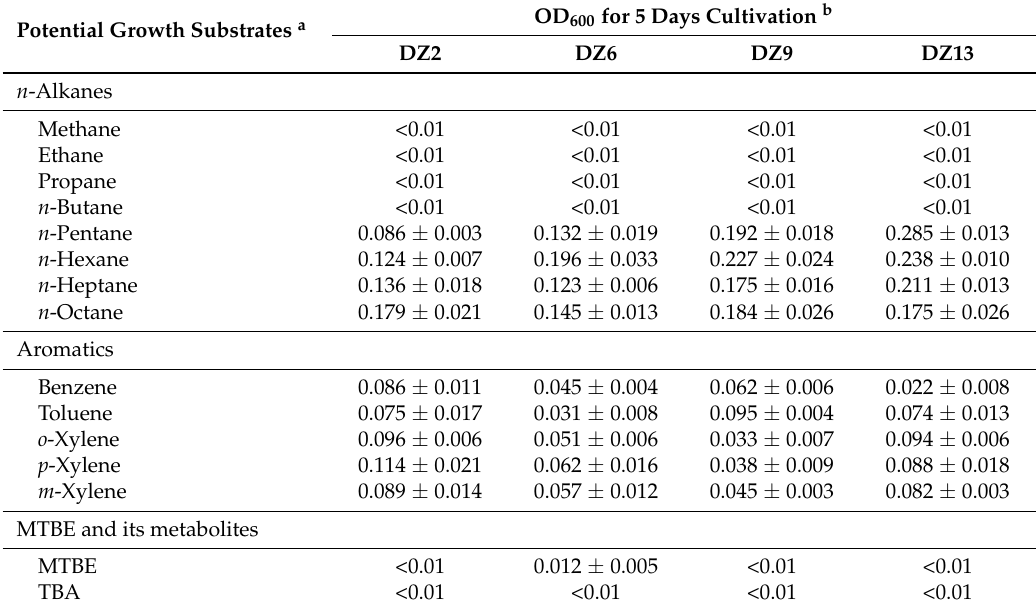
Table 1. The cell growth of the different single strains on potential growth